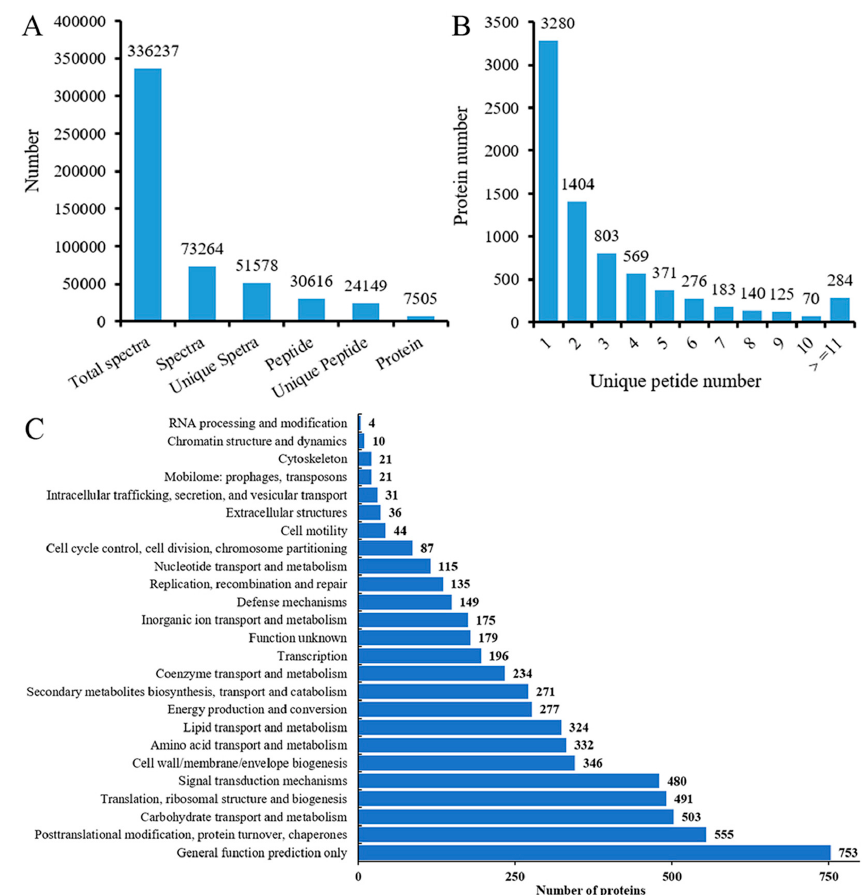
Figure 2. Statistics of root protein identification results: ( A ) Protein identification overview ( B ) Distribution of unique peptide number. False discovery rate (FDR) ≤ 1%. ( C ) COG annotation analysis of all proteins.